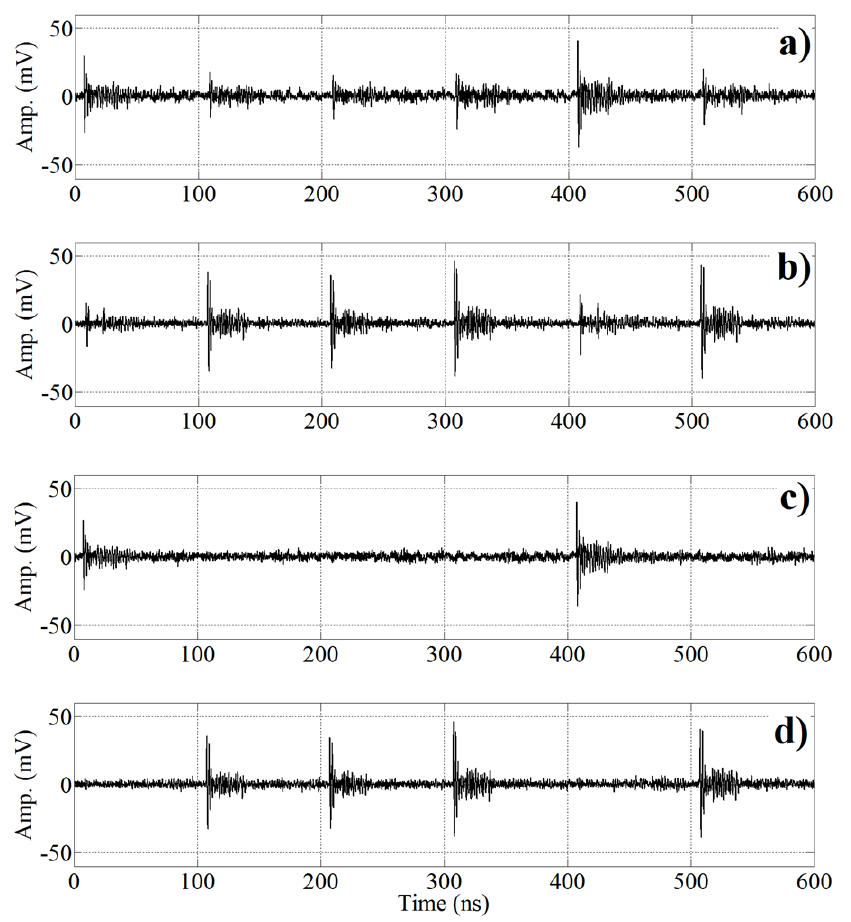
Figure 5. Example of the signals involved in the different stages of the algorithm. ( a ) UHF signal at sensor x 1 , ( b ) UHF signal at sensor x 2 , ( c ) Estimated signal y 1 ( t ) , and ( d ) Estimated signal y 2 ( t )